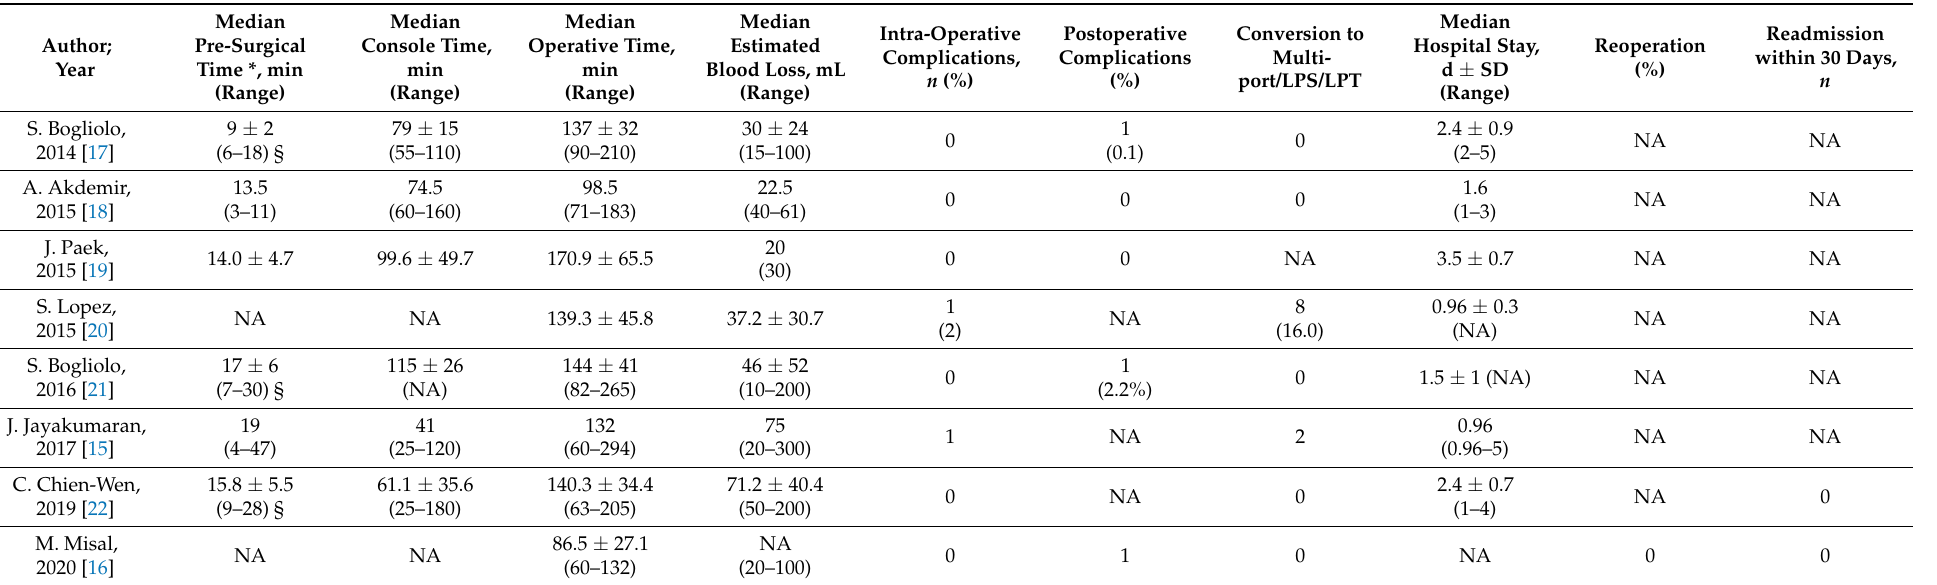
Table 3. Studies’ outcomes (intraoperative and